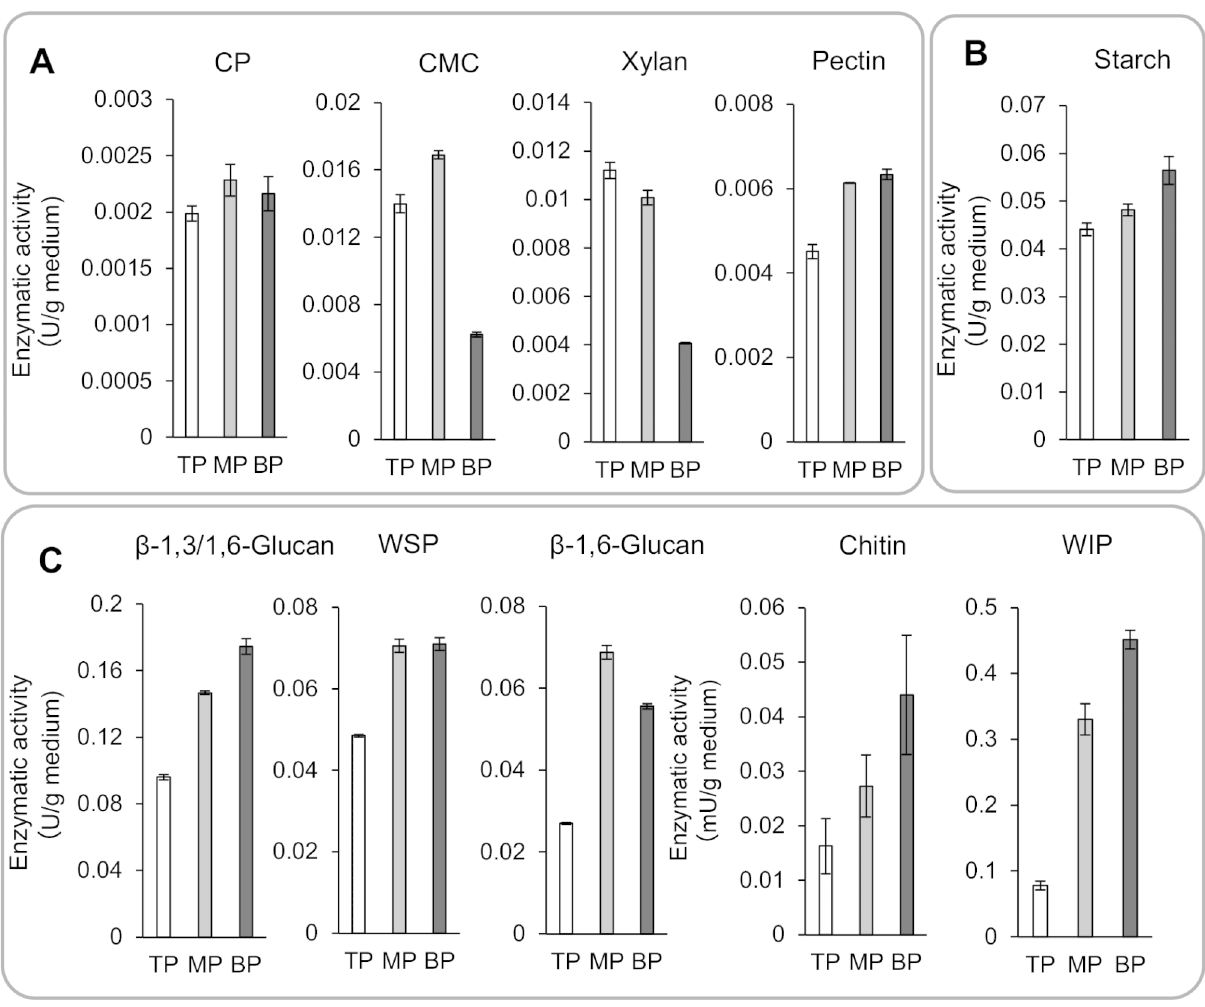
Fig. 2 Carbohydrate hydrolase activities in the sawdust medium cultivated for 27 days Activities were measured using various substrates: (A) plant cell wall polysaccharides such as cellulose powder (CP), sodium carboxymethyl cellulose (CMC), 4-O-methyl-D-glucurono-D-xylan (xylan), polygalacturonic acid sodium salt (pectin), (B) nutritive materials such as soluble starch (starch), and (C) fungal cell wall polysaccharides such as laminarin (β-1,3/1,6-glucan), pustulan (β-1,6-glucan), chitin, hot-water soluble and insoluble cell wall polysac- charides mixture from L. edodes (WSP and WIP). TP, top part; MP, middle part; BP, bottom part. Values are means ± SD of three independent the enzymatic activity for ABTS (Additional file 1: Fig- ure S1). As the result of the column chromatograpies, three partially purified fractions with Lcc activity, P1-1 (1.1 U/mg), P2-1 (11.4 U/mg) and P2-2 (4.9 U/mg), were obtained.These fractions were applied to SDS-PAGE (Fig. 4), and the distinctive bands on the active frac- tions were identified by LC-MS/MS. From the analysis, three laccase candidates, Lcc5 (from P1-1; Accession No., XP_046088042.1; coverage, 10%), Lcc6 (from P2-1; Accession No., BAJ12090.1; coverage, 11%) and Lcc13 (from P2-2; Accession No., BAT31655.1; coverage, 26%), were identified (Additional file 1: Figure S2).